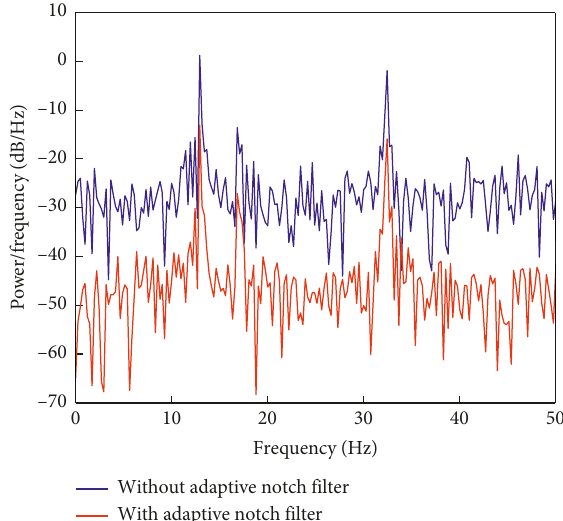
Figure 13: Experiment spectrum of response signal.